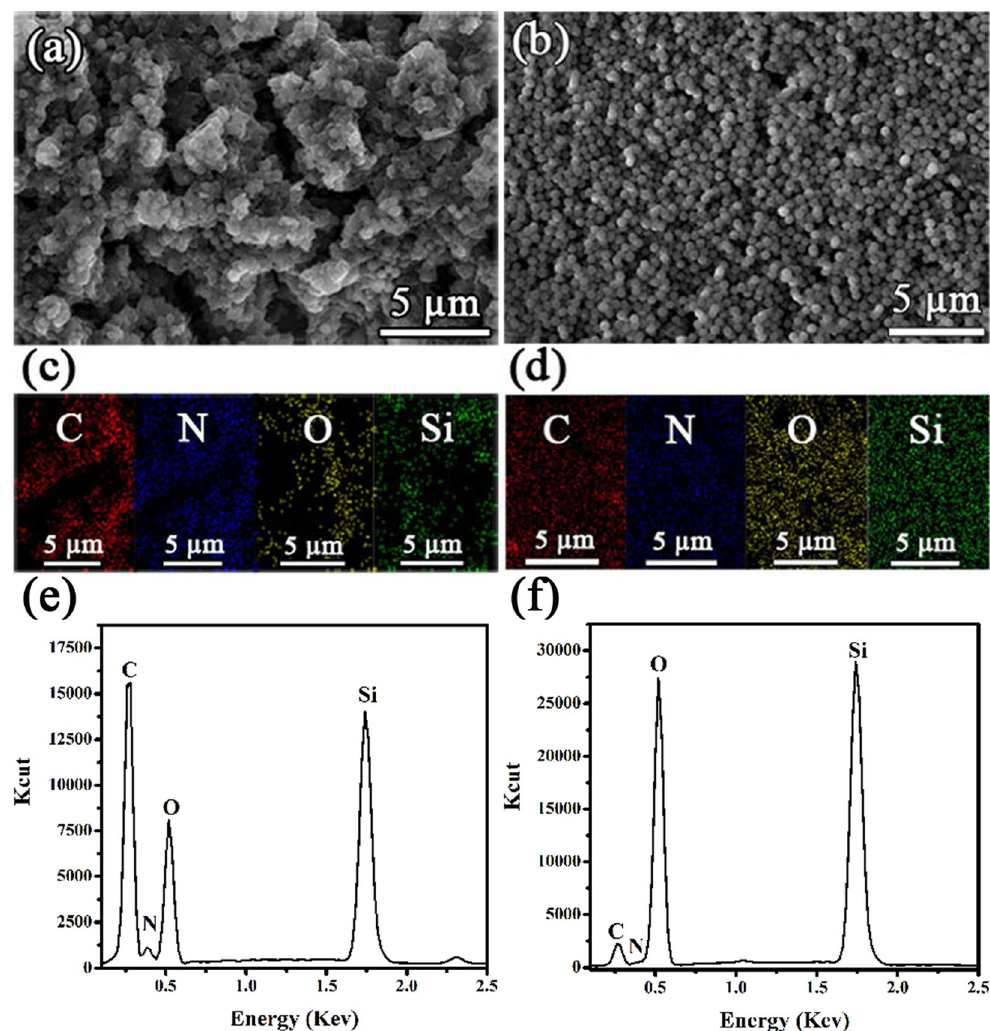
Figure 2. SEM images of ( a ) PDDA/PSC and ( b ) PSC/TMS-SiO 2 coatings, elemental mappings of ( c ) PDDA/ PSC and ( d ) PSC/TMS-SiO 2 coatings, EDX spectra of ( e ) PDDA/PSC and ( f ) PSC/TMS-SiO 2 coatings,